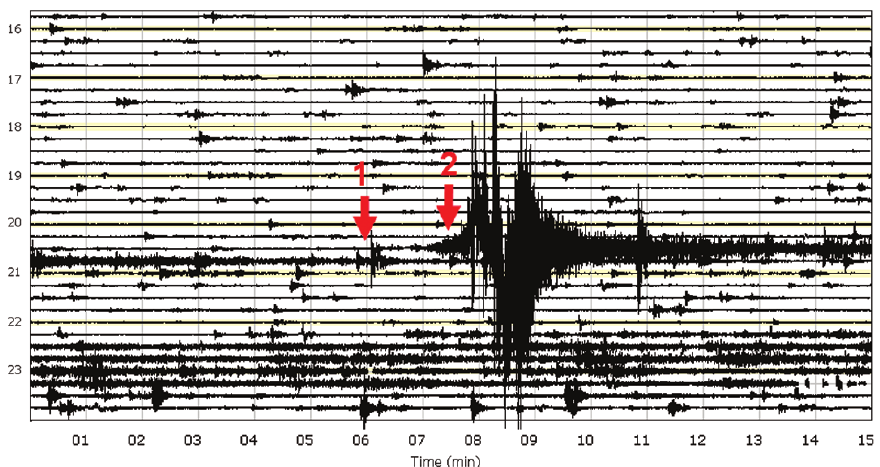
Fig. 13. The seismic signal of the March 15 explosion recorded by the STR1 station (vertical component). No- tice the Ultra Long Period (ULP) component (period of more than one minute). The moments of the beginning of the ULP signal (arrow 1) and the beginning of the explosion (arrow 2) are shown. The ULP onset is very grad- ual. The beginning time of the explosion is retrieved from infrared camera records.